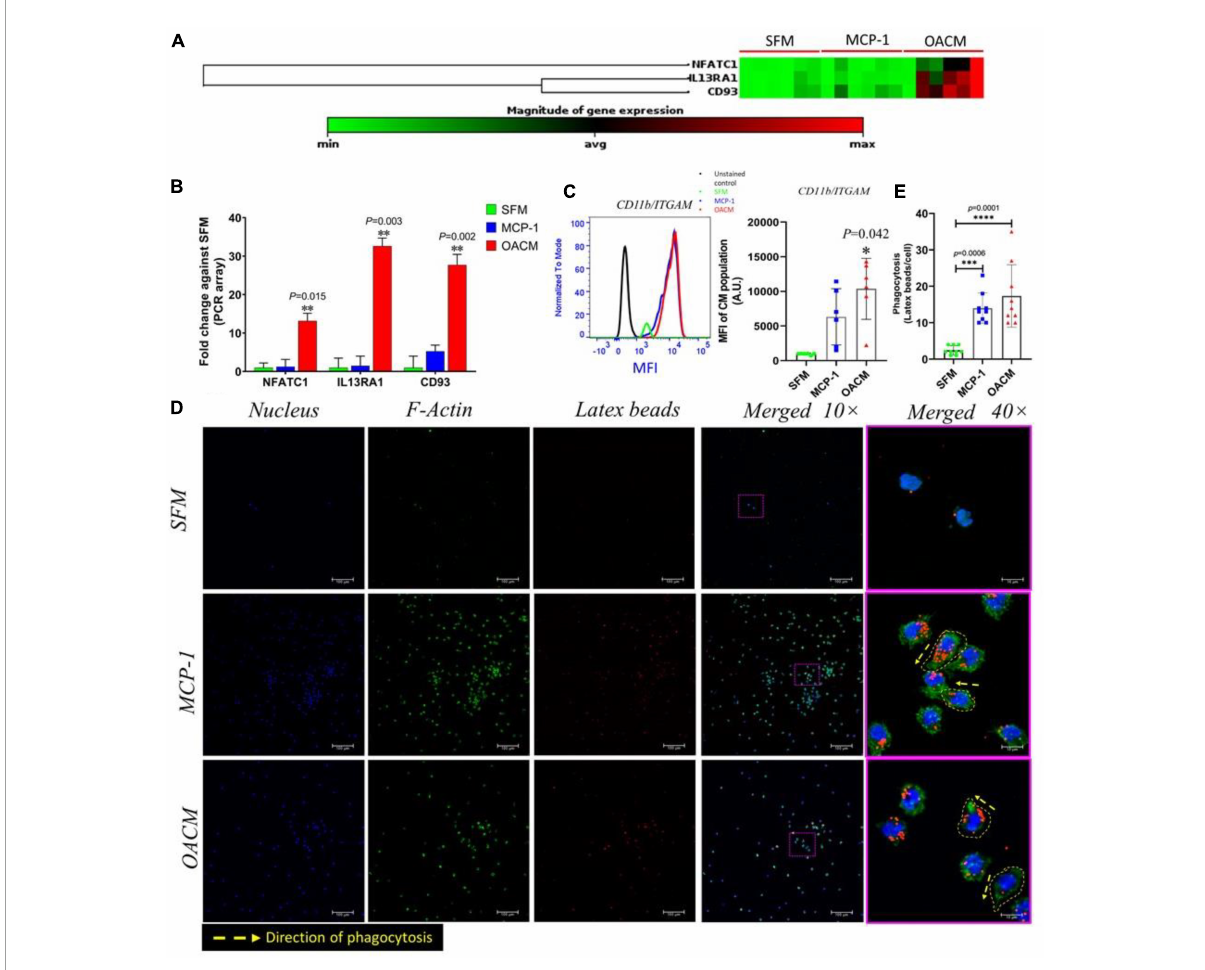
FIGURE7 The phagocytosis potential of migrated monocytes in response to SFM, MCP-1, and OACM. (A) Heatmap of gene expression array of NFATC1, IL13RA1, and CD93 genes. (B) The fold-change of genes against monocytes migrated in SFM. (C) FACs analysis of CD11b/ITGAM receptor. (D) Confocal photomicrographs of monocytes internalized with latex beads at 10 × and 40 × magnification. (E) The quantitative analysis of latex beads uptake/cell by migrated cells in response to MCP-1 and OACM against SFM. The assessments were reported to be statistically significant if * p < 0.05, ** p < 0.01, *** p < 0.001 and **** p <